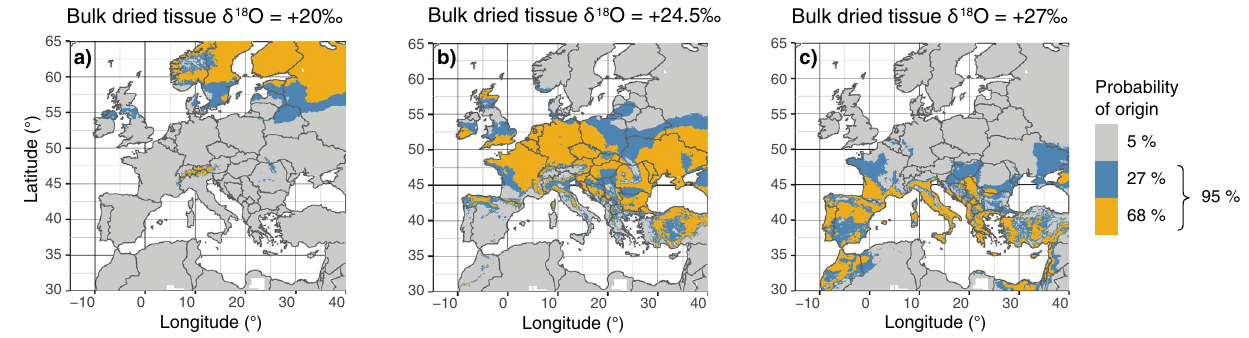
Figure 5. Prediction maps of three strawberry samples of unknown origin collected in July 2017. The prediction model is based on the best berry-specific model (Fig. 3) and shows the probability of origin (higher than 32% in yellow, 5% to 32% in blue, and lower than 5% grey). Bulk dried tissue δ 18 O value of sample: ( a ) + 20 ‰ (mean Finish/Swedish sample), ( b ) + 24.5 ‰ (mean German sample), and ( c ) + 27 ‰ (mean southern European sample). Prediction maps were calculated by subtracting the δ 18 O values of the bulk dried tissue of the suspected sample from the mapped results of the best berry-specific model. This resulted in a map showing the places that are predicted to have the same δ 18 O values as the sample as a value of zero. The bigger the difference shown on the map, the lower the probability of provenance of the sample. Based on the prediction error of the best berry-specific model (RMSE = 0.96 ‰), the one sigma (68%, yellow) and two sigma (95%, yellow and blue) confidence intervals around the areas showing no difference to the δ 18 O value of the suspected sample can be shown. The three maps were created using the software R, version 3.5.3 (https:// www.r- proje ct.